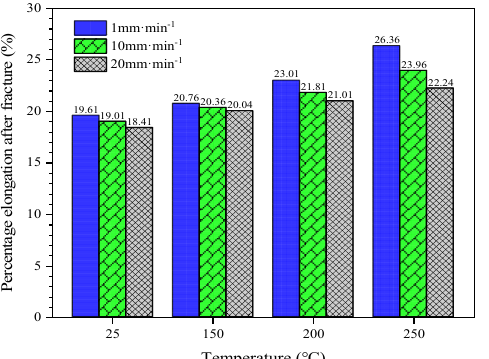
Figure 6. The true stress and true strain of AZ31B at different experiment temperatures under each strain rate. ( a )